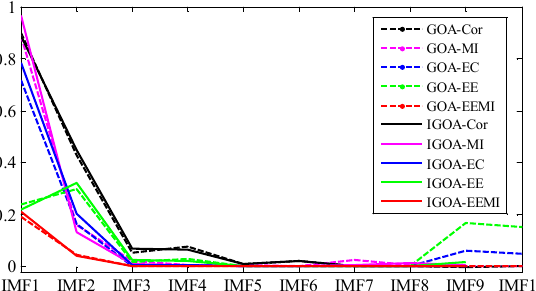
Figure 18. Decomposition results evaluation of outer ring slight damage signal.